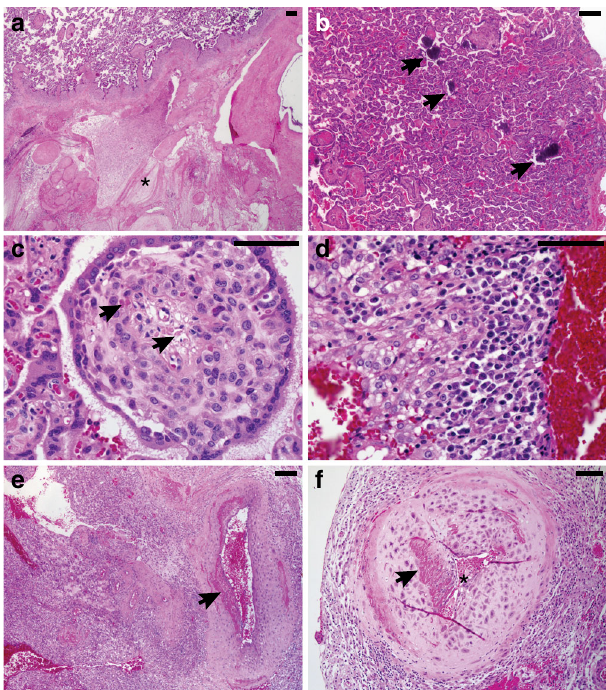
Fig. 5 Uteroplacental histopathology of ZIKV-infected cases compared with gestational-age-matched negative controls. a All fi ve ZIKV-infected cases showed placental infarctions (asterix) with large gross infarctions seen in the cases infected at days 31 – 51. b ZIKV cases had conspicuous villous stromal calci fi cations (arrows), which are a consequence of stromal fi broblast cell death ( c ). ZIKV cases were positive for chronic decidualitis with plasma cells and lymphoplasmacytic leuokocytoclastic vasculitis ( d ), which was associated damage to the uterine spiral arteries ( e ) and vascular luminal (astericks) narrowing ( f ). Scale bar is 100 µ